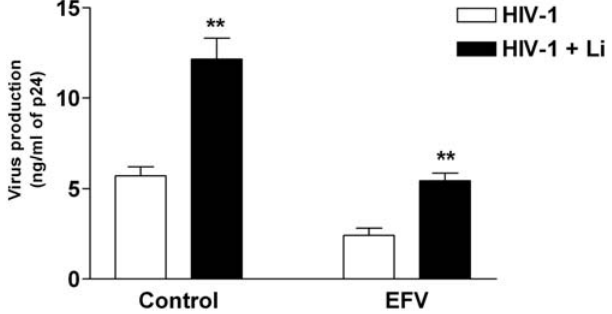
Figure 2. Virus replication is increased in both DCs and CD4 + T cells by Leishmaniainfantum amastigotes. First, iDCs were either left untreated (Control) or treated with the antiviral agent EFV. Next, cells were pulsed for 60 min with NL4-3Bal env and either left unexposed or exposed to Leishmania infantum amastigotes (Li). Finally, iDCs were cocultured with autologous CD4 + T cells. Virus production was estimated by measuring p24 levels in the culture supernatants at 4 days following initiation of the coculture. Data shown represent the means 6 SEM of triplicate samples and are representative of five independent experiments. Asterisks denote statistically significant differences from the cells infected with HIV-1 only (**, P , 0.01).